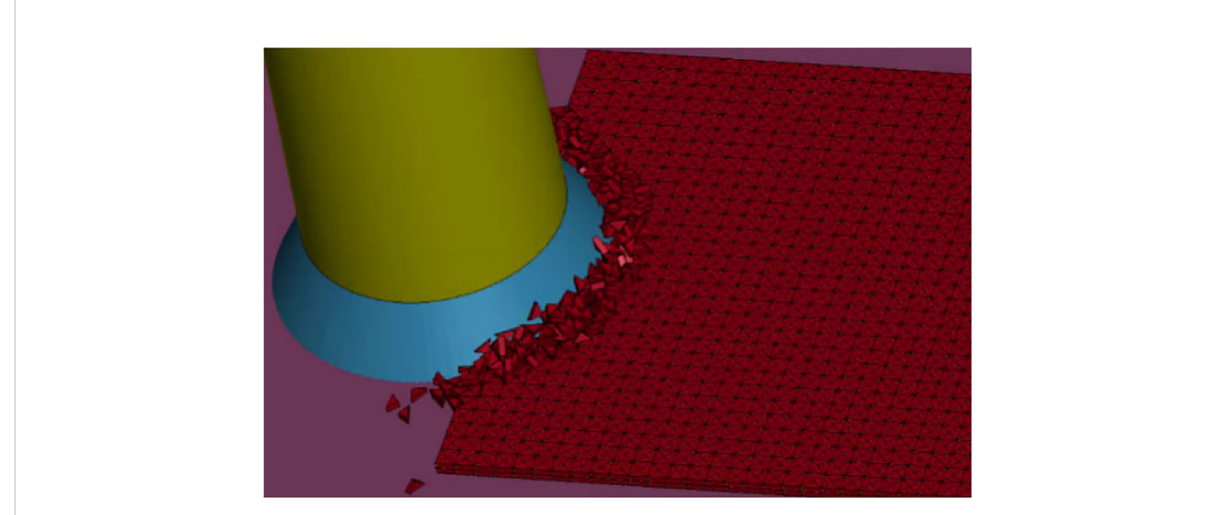
FIGURE 10 Bending failure mode of the sea ice